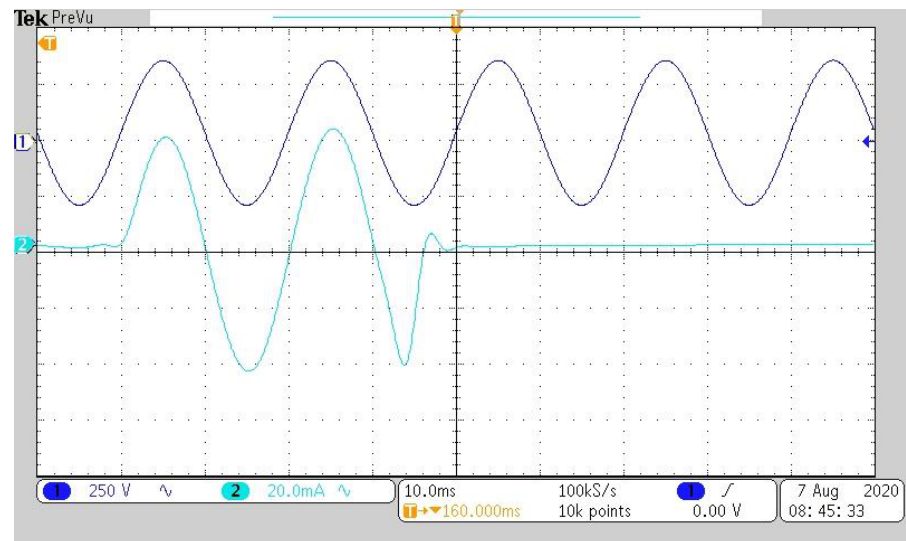
Figure 11. Supply voltage (channel 1) and disconnection current (channel 2) vs. time for RCD-2 (Table 3), with an input of 30 mA (50 Hz) and measured break time of 35 ms. The MRP-201 meter enabled the measurement of the RCD break time with excitation by currents of various shapes. Table 4 presents the obtained response times of the tested circuit breakers for the selected waveforms of the test current. Table 4. A summary of RCD break times obtained with MRP-201 meter for various shapes of test current excitations (50 Hz). Notation